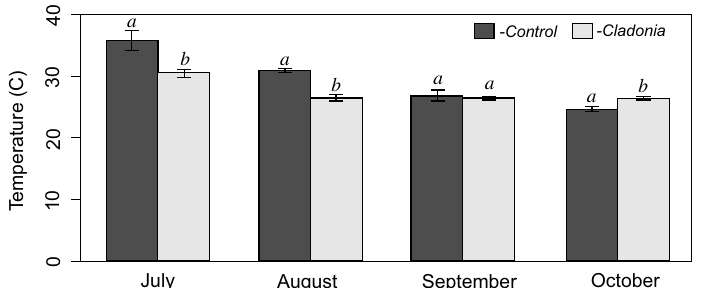
Supplementary Figure 1. Substrate temperature for the two control modules and eight Cladonia modules during the 2012 growing